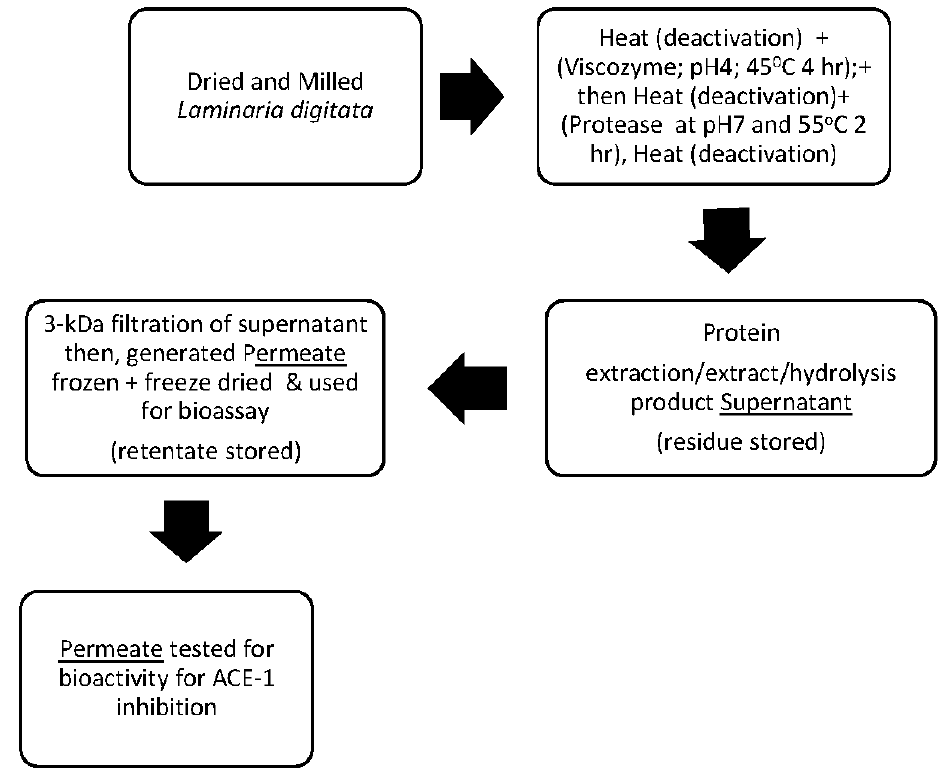
Figure 1. Schematic representation of the process used to generate ACE-1 inhibitory permeates from L. digitata. Briefly, milled and dried L. digitata was heat deactivated and hydrolysed with two enzymes—Viscozyme ® and Alcalase ® . Hydrolysates were filtered to generate permeate and retentate fractions using a Millipore Lab scale TFF system and a 3 kDa cellulose filter. Fractions were subsequently tested for their ability to inhibit the ACE-1 enzyme using a spectrophotometric